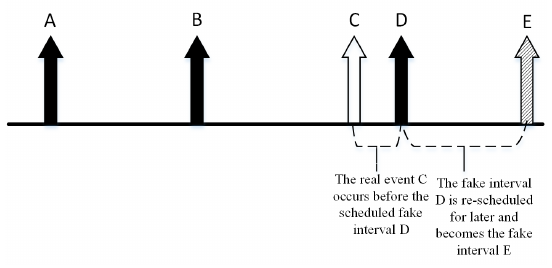
Figure 4. An example of the FitProbRate